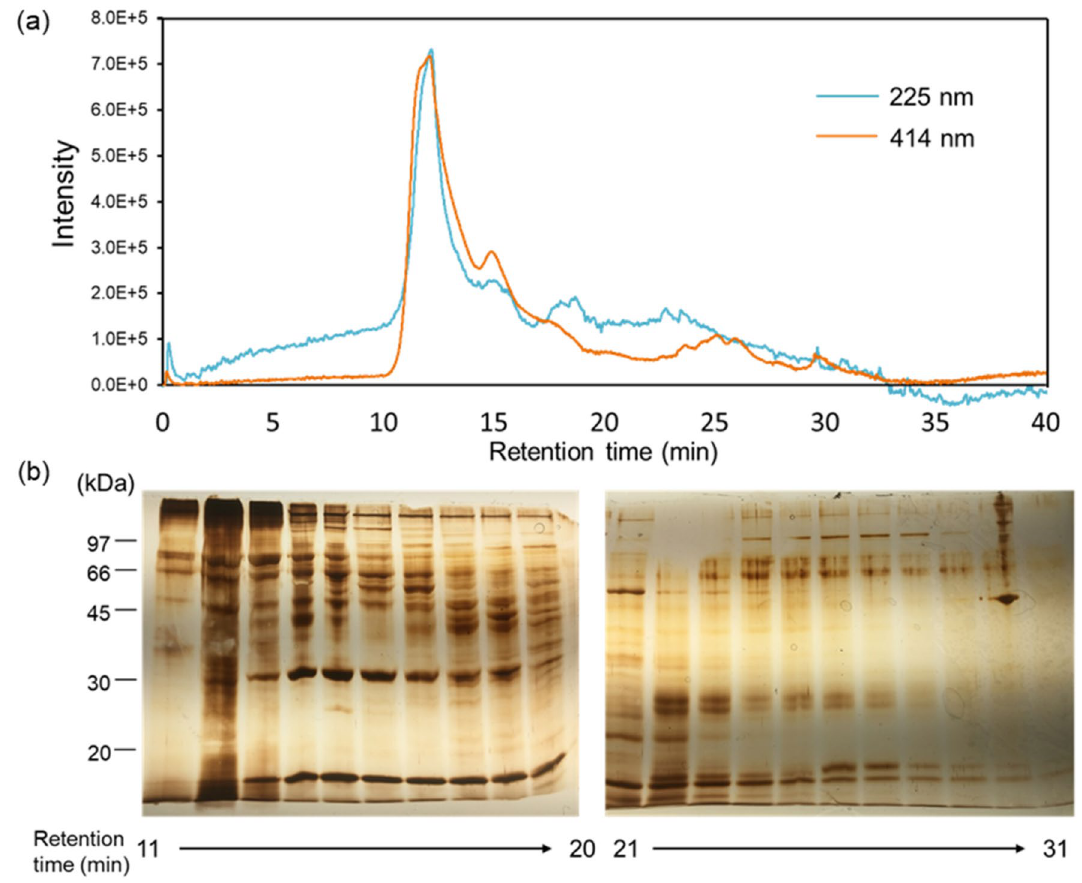
Figure 2. Detection and identification of Cd-binding proteins by post-column method. ( a ) The supernatant of the extracted visceral was separated by HPLC on an YMC Pack Diol-120 gel filtration column (4.6 mm × 300 mm) with post-column method. The cyan line is the signal detected at 225 nm, indicating the presence of peptides and other substances in the sample. The orange line is the signal detected at 414 nm, indicating the presence of free TPPS. ( b ) The supernatant of the extracted visceral was separated by HPLC on an YMC Pack Diol-120 gel filtration column (4.6 mm × 300 mm) without flowing the post-column solution were fractionated every 1 min, and each fraction was subjected to SDS–PAGE. From left to right are the grouping of gels cropped from two different pieces of gels, the fractions collected with retention times from 11 to 31